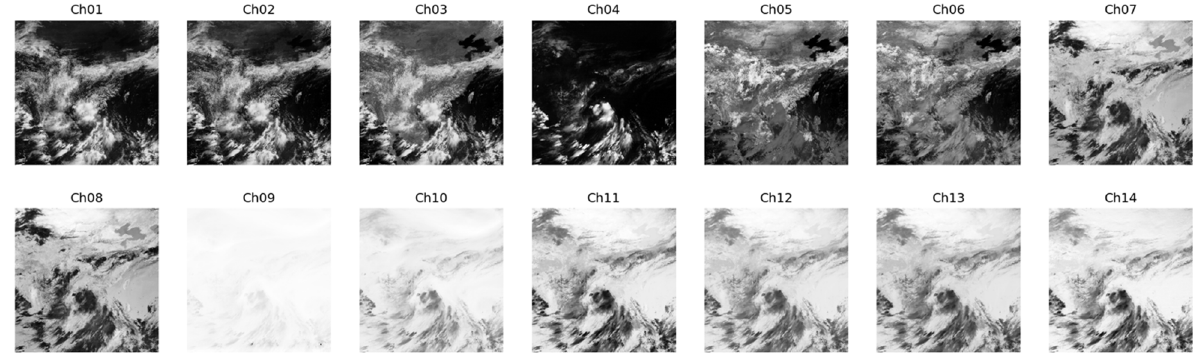
Figure 1. Examples of AGRI all-channel observation images.